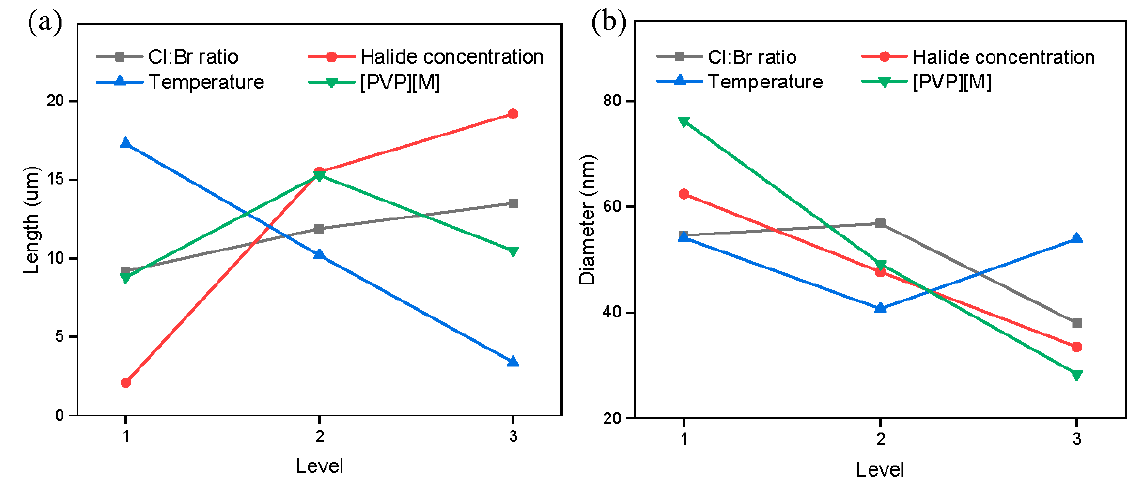
Figure 2. Significance analysis of the effects of the four synthesis parameters with three-level variations on ( a ) length and ( b ) diameter of AgNWs synthesized by Taguchi DOE in Table 2.